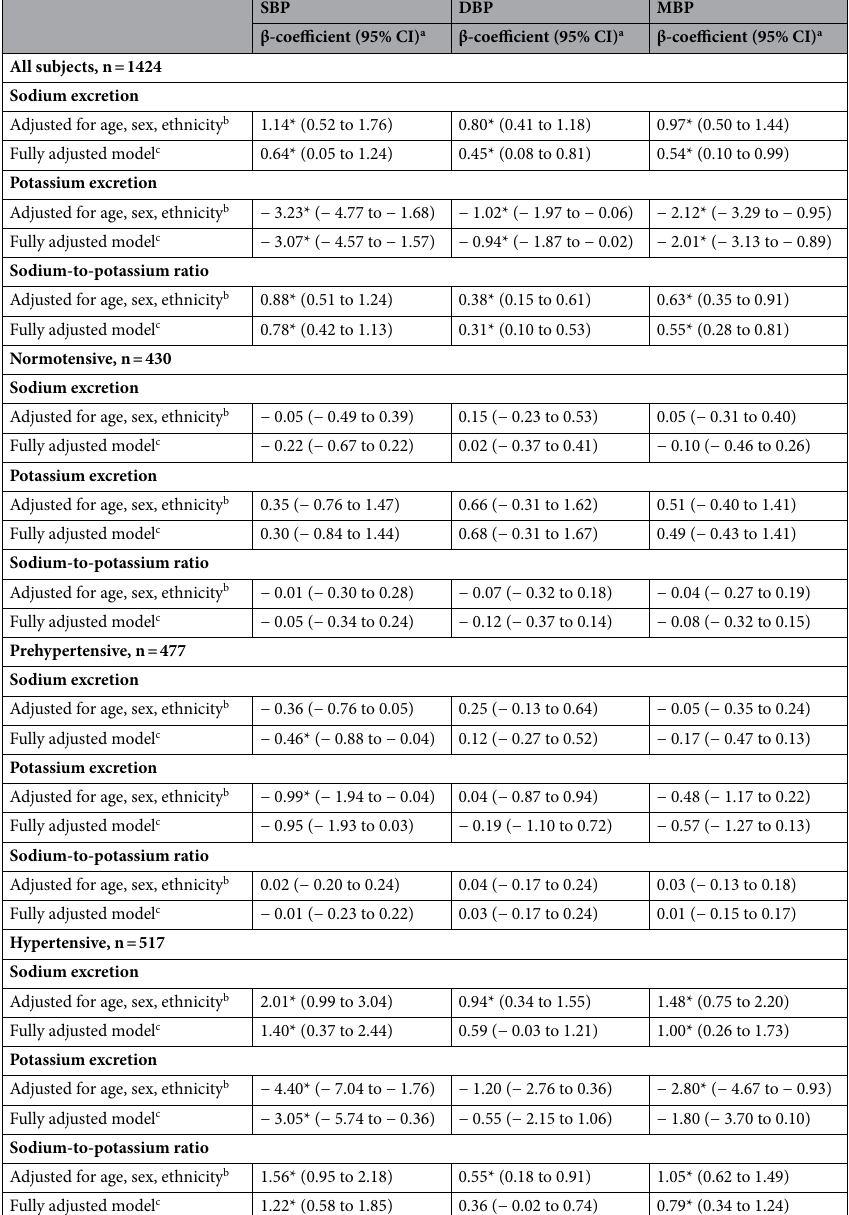
Table 3. Association between 24-h urinary sodium and potassium excretion and their ratio with blood pressure. a β-coefficients for sodium and potassium indicate the change in mm Hg of blood pressure associated with per 1000 mg difference in excretion; β-coefficients for the ratio of sodium-to-potassium indicate the change in mm Hg of blood pressure associated with each 1-unit increase in molar ratio. b Preliminary adjusted model including age, sex, and ethnicity. c Fully adjusted models included age, sex, and ethnicity plus body mass index, education level, history of cardiovascular disease, diabetes mellitus status, self-reported chronic kidney disease, antihypertensive medication use, smoking status, alcohol use status, and physical activity. In addition, sodium intake was adjusted in the regression models for potassium, and vice versa, and the models for the sodium-to-potassium ratio did not adjust for sodium and potassium excretion. * P < 0.05 for β-coefficient in the regression